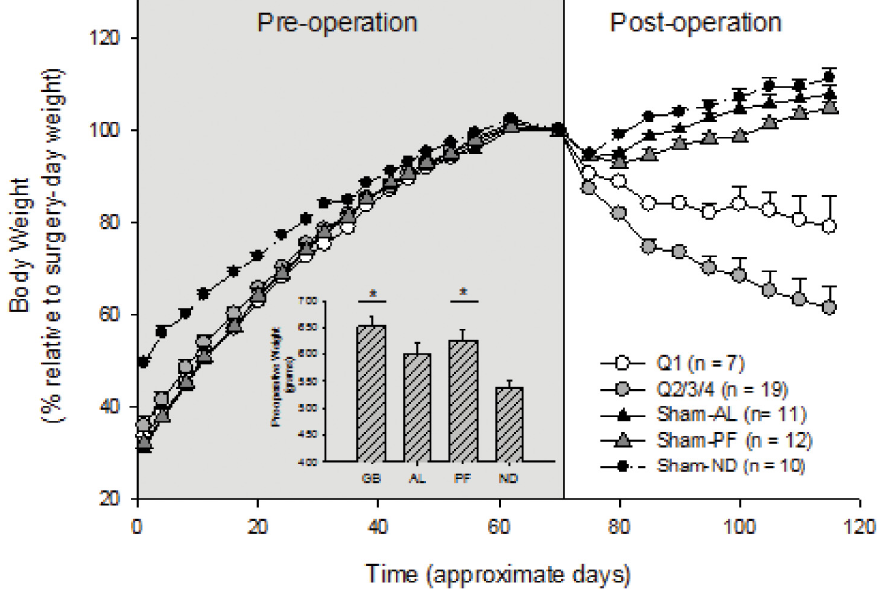
Fig 2. Gastric bypass effectively reduced body weight following diet-induced obesity. Pre-operative body weights during diet-induced obesity (establishment phase) are shown in the shaded region. Weight loss following surgery, specific to the RYGB animals, is shown in the non-shaded region, with a more pronounced difference in the Q2/3/4 sub-group. The inset shows the differences in body weights, following group- assignment, the day before experimental or sham surgeries ( * p < 0.05 compared to Sham-ND; no difference between Q1 and Q2/3/4 before surgery, not shown).